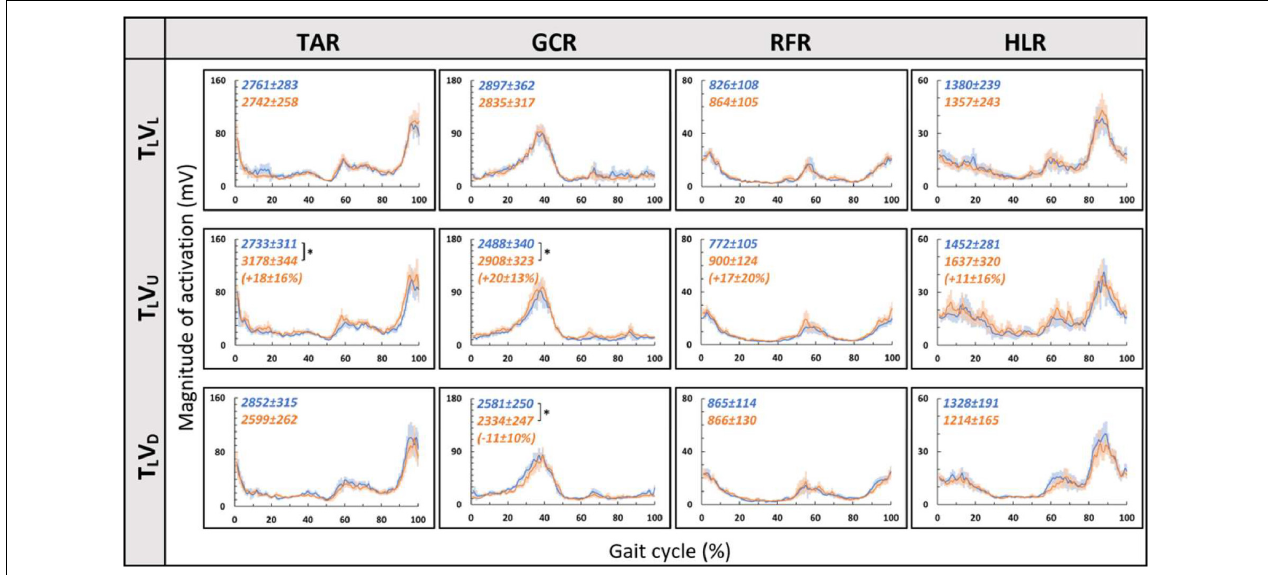
FIGURE 5 | Visual inclinations do not affect muscle activation patterns for leveled treadmill inclination. The X -axis represents the percentage of the gait cycle (%), and the Y -axis represents the magnitude of muscle activation (mV). Top row—leveled vision (0 ◦ , as in Figure 4 top row), middle row—vision up (+10 ◦ ), and bottom row—vision down ( − 10 ◦ ). The blue lines represent the pre-transition and the orange lines represent post-transition activity. Numerical values superimposed on the panels represent the average magnitude of activation ± SE for pre-transition (blue) and post-transition (orange), and in parentheses, the significant changes (in %) between these conditions. t -test, * p < 0.0125 ( N = 12). Despite the significant effects in the magnitude, we found that the EMG temporal patterns were highly comparable; see correlation analyses in Table 2 .